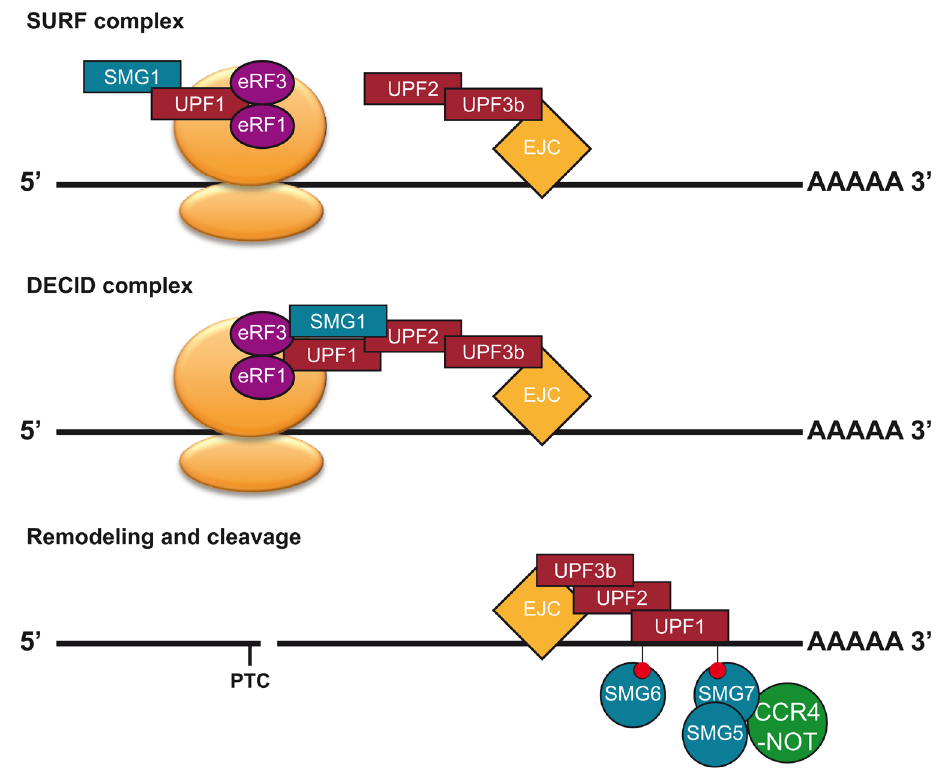
Figure 1. The model of NMD activation in animals. At termination events, UPF1 and SMG1 are recruited to termination events by eRF1 and eRF3, leading to the formation of the SMG1-Upf1-eRF1-eRF3 (SURF) complex 22 . Further recruitment of UPF2 and UPF3 (UPF3b in mammals) leads for the formation of a decay-inducing (DECID) complex 20,46 . This will lead to the phosphorylation of UPF1 by SMG1. Then the ribosome will disassociate and SMG5/6/7 will be recruited to transcript through phos-UPF1 binding. The transcript is degraded by endonucleolytic cleavage by SMG6 and the CCR4-NOT complex is recruited by SMG7/5. UPF2 and UPF3 can be recruited to NMD targeted transcripts by the EJC, although many transcripts a degraded without the presence of an EJC 47,48 .